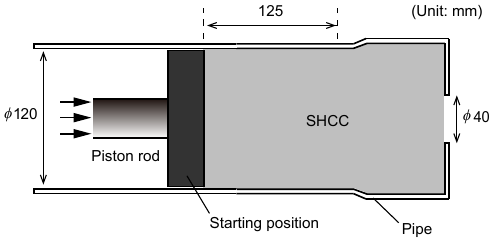
Figure 1. Schematic view of ram-extrusion test